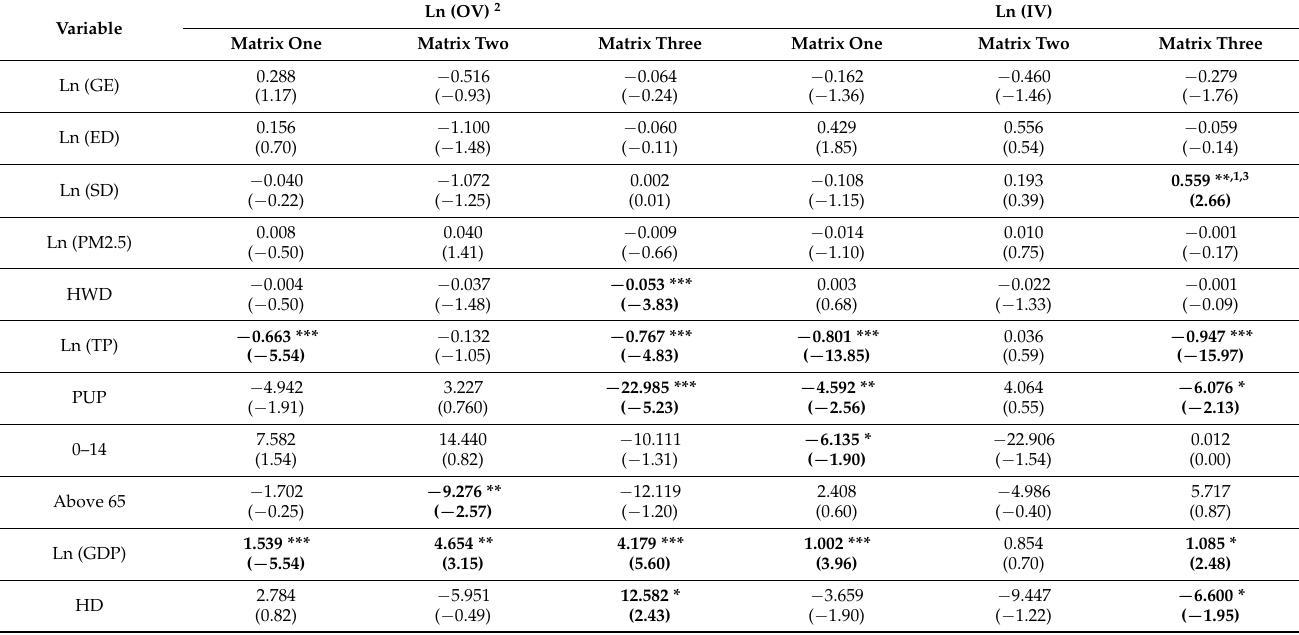
Table 7. Spill-over effects of the independent variables on